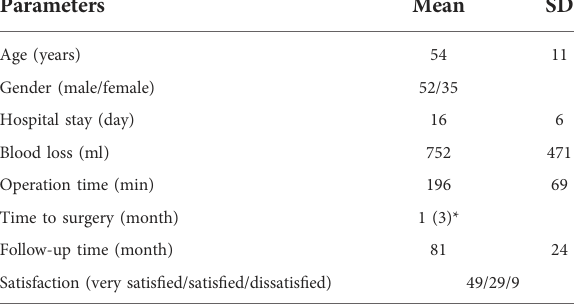
TABLE 1 Baseline clinical data of patients ( n =87).